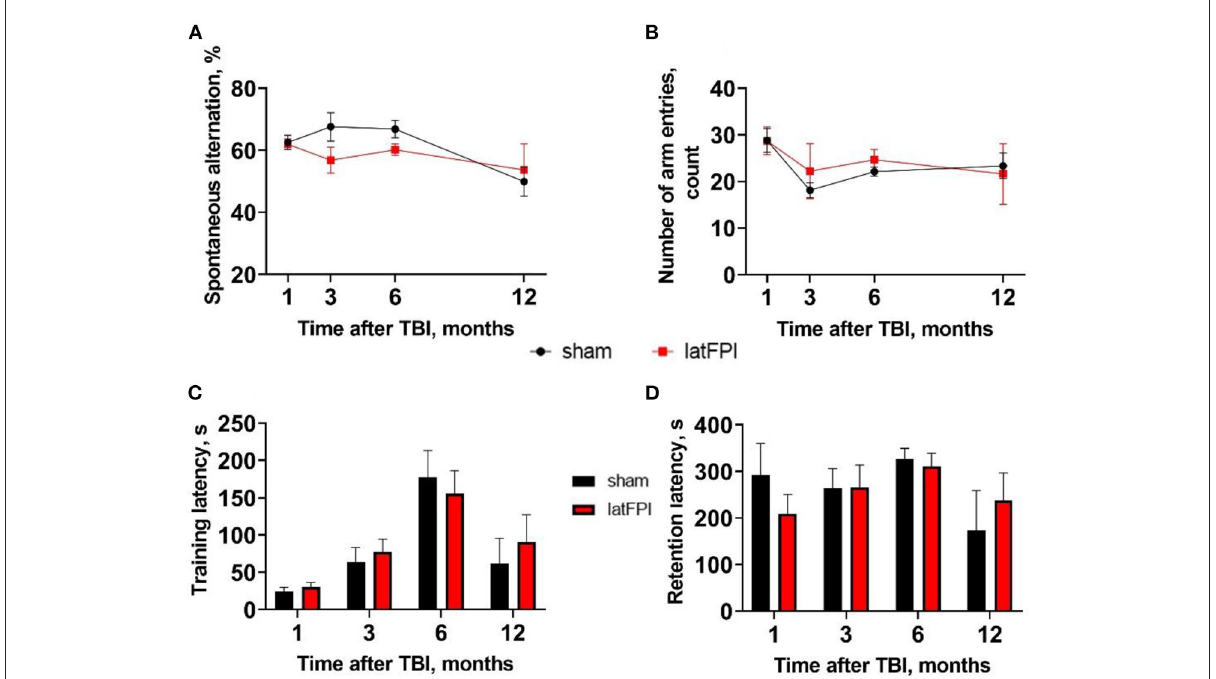
FIGURE6 Assessment of working and contextual memory after latFPI. Spontaneous alternation behavior (A) and the number of arm entries (B) in the Y-maze test 1, 3, 6, and 12 months after latFPI. Latency time to enter dark compartment on the training (C) and retention day (D) in the passive-avoidance test 1, 3, 6, 12 months after latFPI in mice. Data are expressed as mean ± SEM (two-way RM ANOVA followed by Fisher’s LSD test).